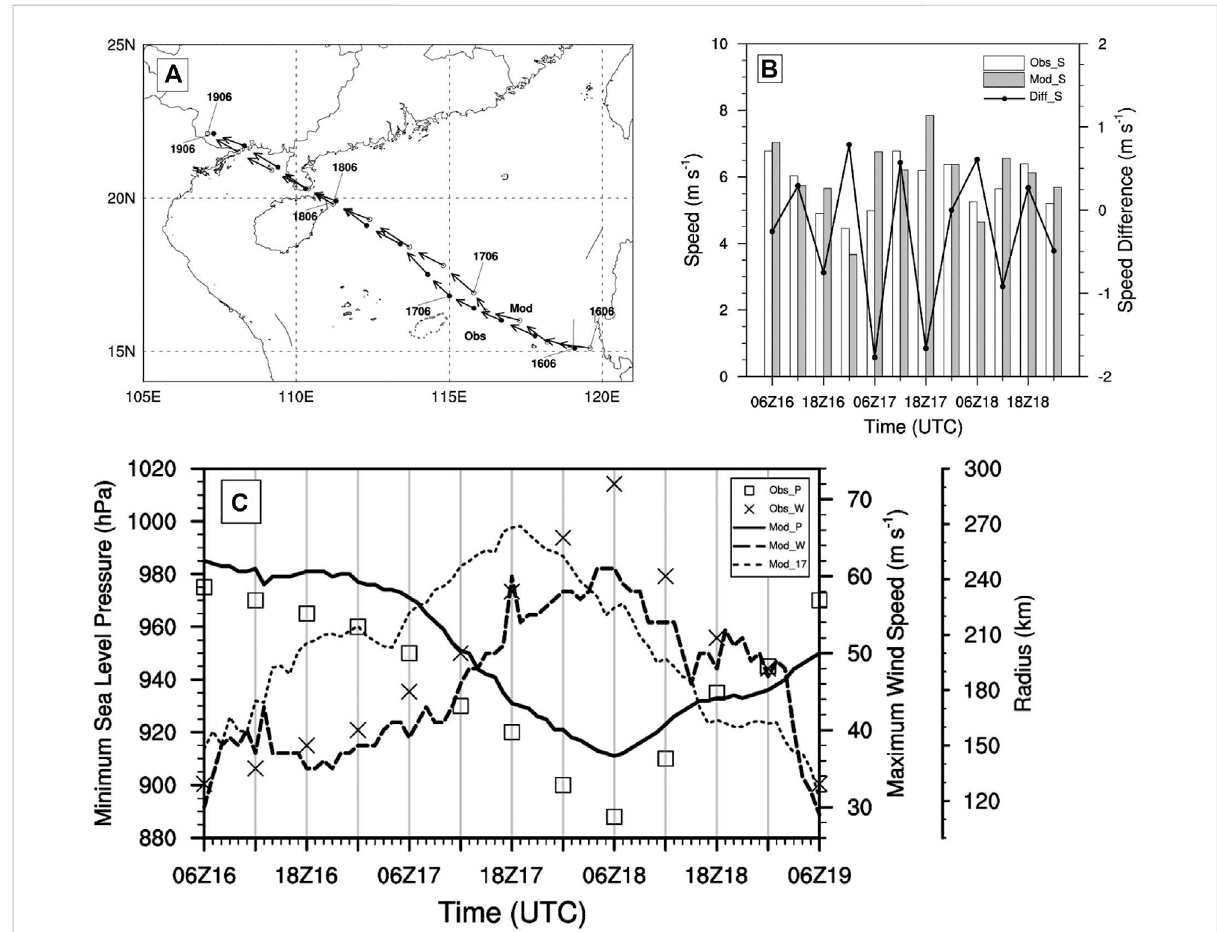
FIGURE 1 Observed and simulated (A) tracks, (B) speed (histogram, units: m s − 1 )and speed deviation (dotted line, units: m s − 1 ), (C) time series of maximum wind speed (observation: crosses, simulation: dashed lines, units: m s − 1 ), and minimum sea level pressure (observation: squares, simulation: solid lines,units:hPa)ofRammasunfrom0600UTC16Julyto0600UTC19July2014.Thearrowlengthin (A) representsthespeedandthedirctionofthe arrow represents the direction of movement. The short dashed line in (C) represents the average radius with 17 m s − 1 of 10-m